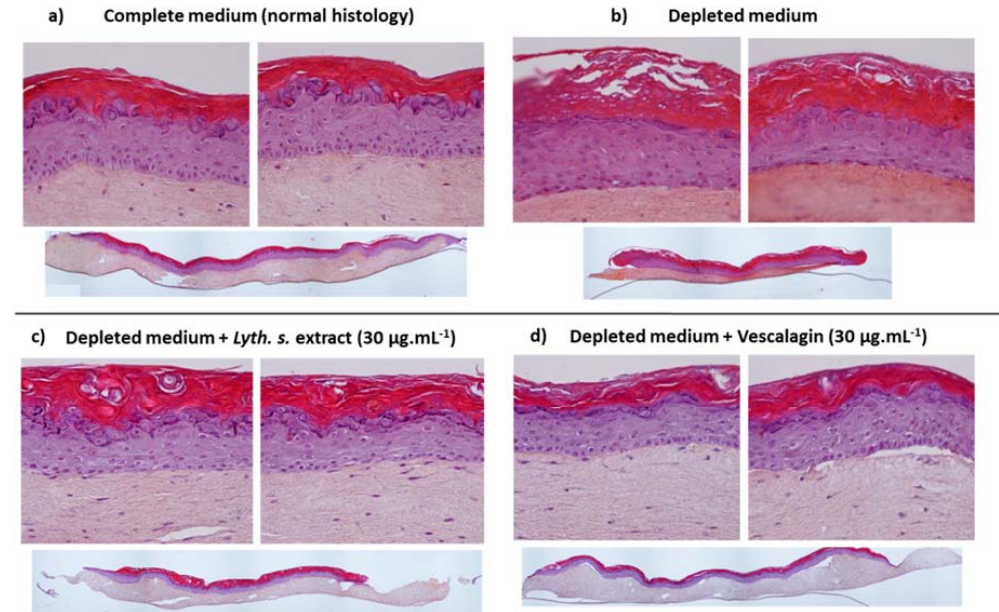
Figure 5. Evaluation of the impact of Lyth. s. extract and vescalagin on full thickness reconstructed skin architecture. Histological cross ‐ sections of full thickness reconstructed skins were performed after nine days of incubation of the skin: ( a ) in complete medium; ( b ) in depleted medium; and, ( c ) in the presence of Lyth. s. extract or ( d ) vescalagin.